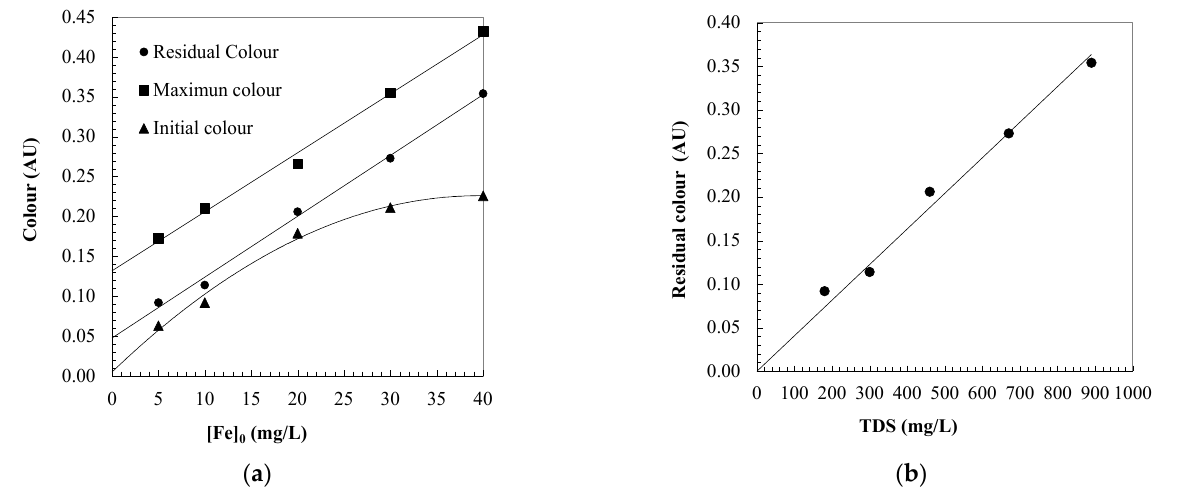
Figure 8. ( a ) Effect of iron dosage on water colour levels observed during the carbamazepine oxidation. ( b ) Relation-ship between total dissolved solids and the residual colour of water oxidized. Experimental conditions: [CBZ] 0 = 50.0 mg/L; pH = 3.0; [H 2 O 2 ] 0 = 15.0 mM; [UV] = 150 W; T = 40 °C.